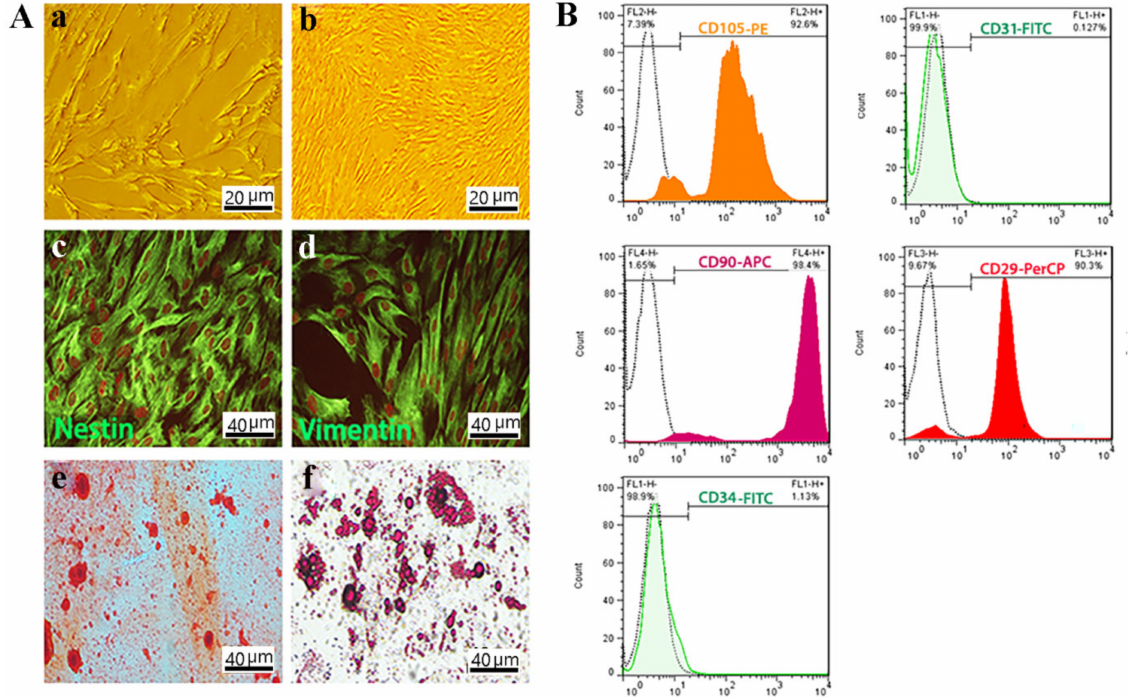
Figure 2. OE-MSCs characterization. ( A ) Morphology of OE-MSCs in passage one. Scale bar: 20 µ m; ( a , b ) Morphology of OE- MSCs in passage three which was described as a spindle-like morphology. Scale bar: 10 µ m; Immunocytochemistry of OE- MSCs to characterized specific neural crest and mesenchymal markers; ( c ) nestin; and ( d ) vimentin by immunofluorescence staining. Osteogenic and adipogenic differentiation of OE-MSCs, respectively; ( e , f ) Scale bar: 40 µ m. ( B ) Flow cytometric assessment to characterization of OE-MSCs surface markers; including CD29 as a positive marker; CD31 as a negative marker; CD105 as a positive marker; CD90 as a positive marker; and CD34 as a negative